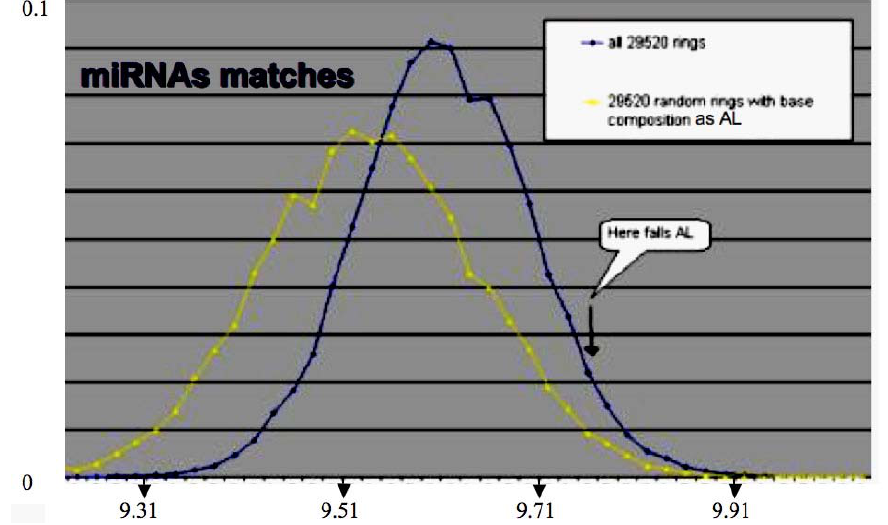
Figure 4. Distribution of the match values between the human miRs and the 29,520 rings solution of the variational problem (blue), and between these miRs and 29,520 random miRs with same base composition as the